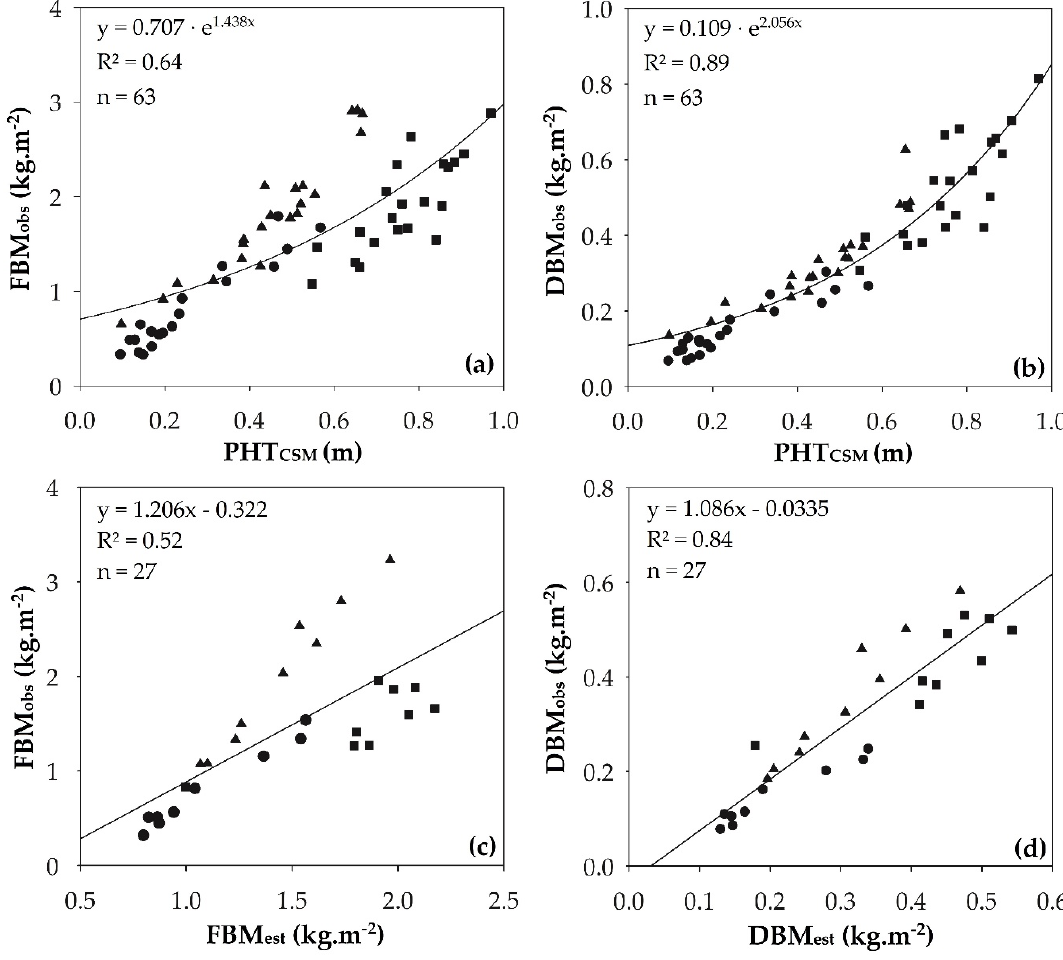
Figure 4. Cross-validation relationship between biomass and PHT CSM for FBM ( a ) and DBM ( b ) from calibration datasets and between observed versus predicted FBM ( c ) and DBM ( d ) derived from validation dataset. Symbols indicate datasets from Mission 1 ( ● ), Mission 2 ( ▲ ), and Mission 3 ( ∎ ).